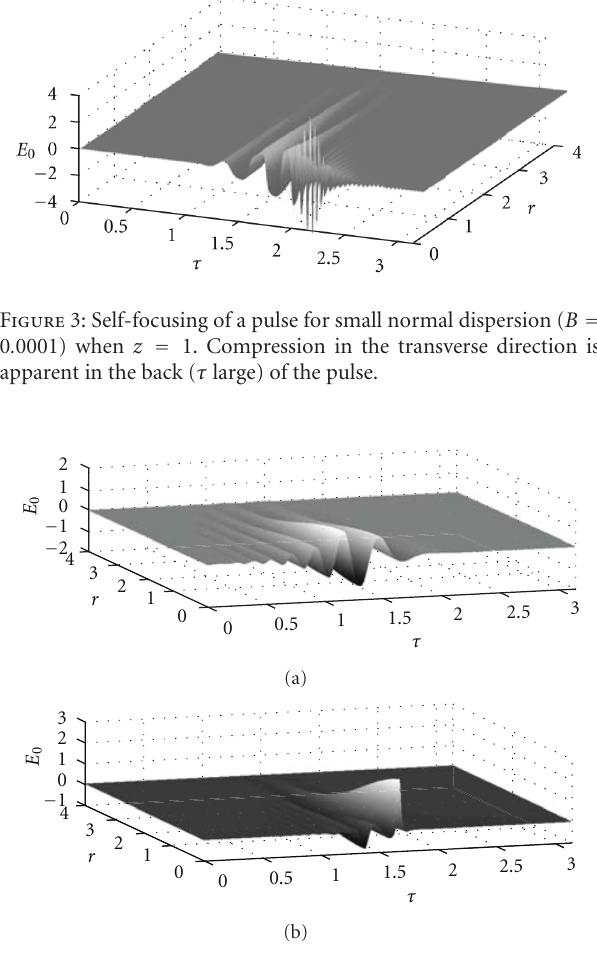
Figure 4: Evolution of a pulse for large ( B = − 1, (a)) and small ( B = − 0 . 001, (b)) anomalous dispersion. In the latter case, there is compression both temporally and in the transverse direction. The bottom figure shows an incipient collapse event that will develop into a singularity with infinite